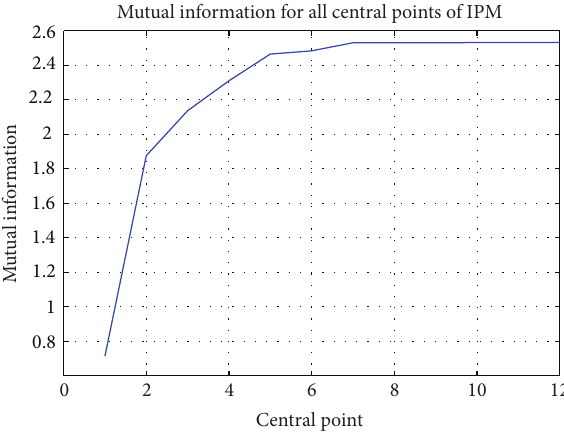
Figure 12: Mutual information for all central points.